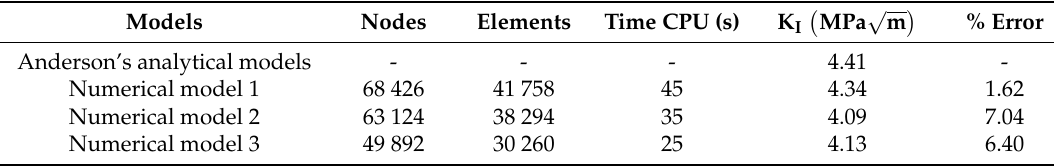
Table 7. Relative error and computational cost on determining K I